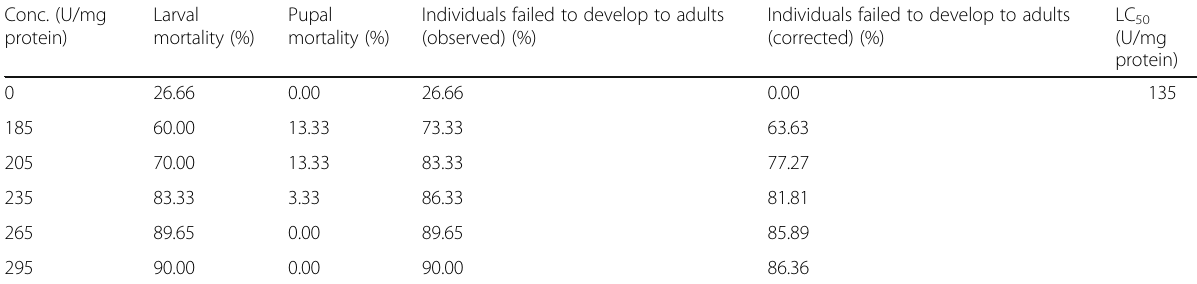
Table 4 Effect of crude chitinase on mortality percentage of different Conc. (U/mg protein)